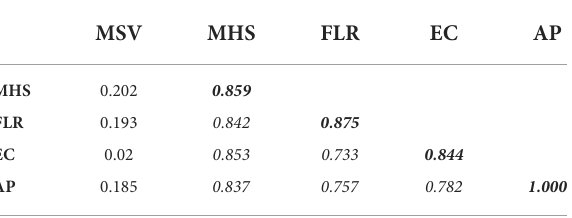
TABLE 3 Discriminant